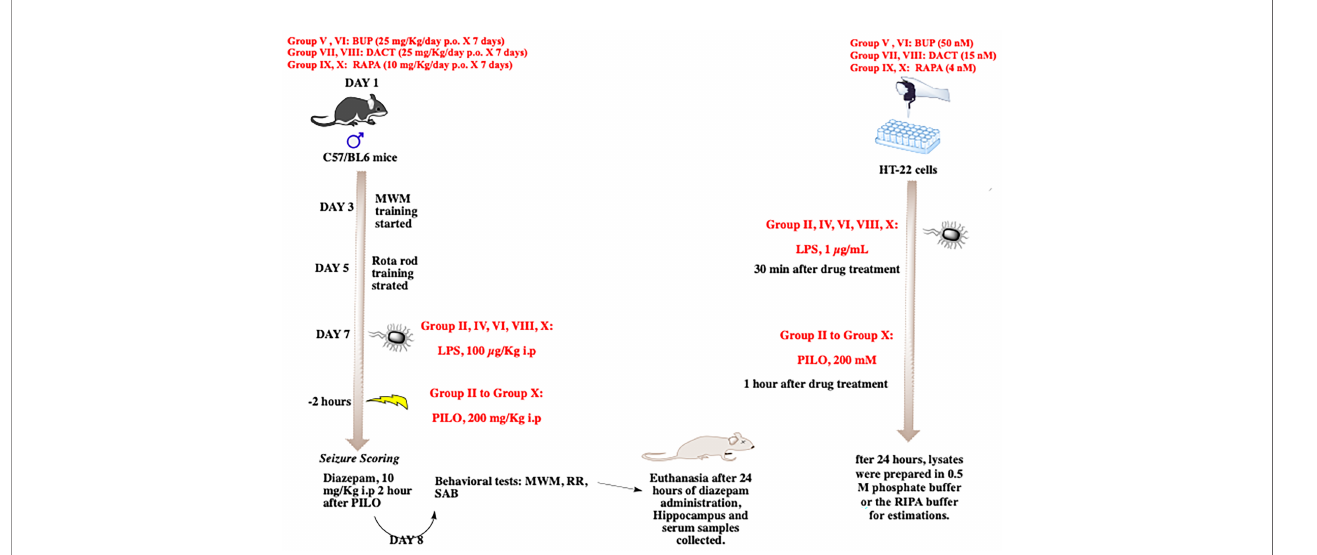
FIGURE 1 | The in vitro and in vivo experimental